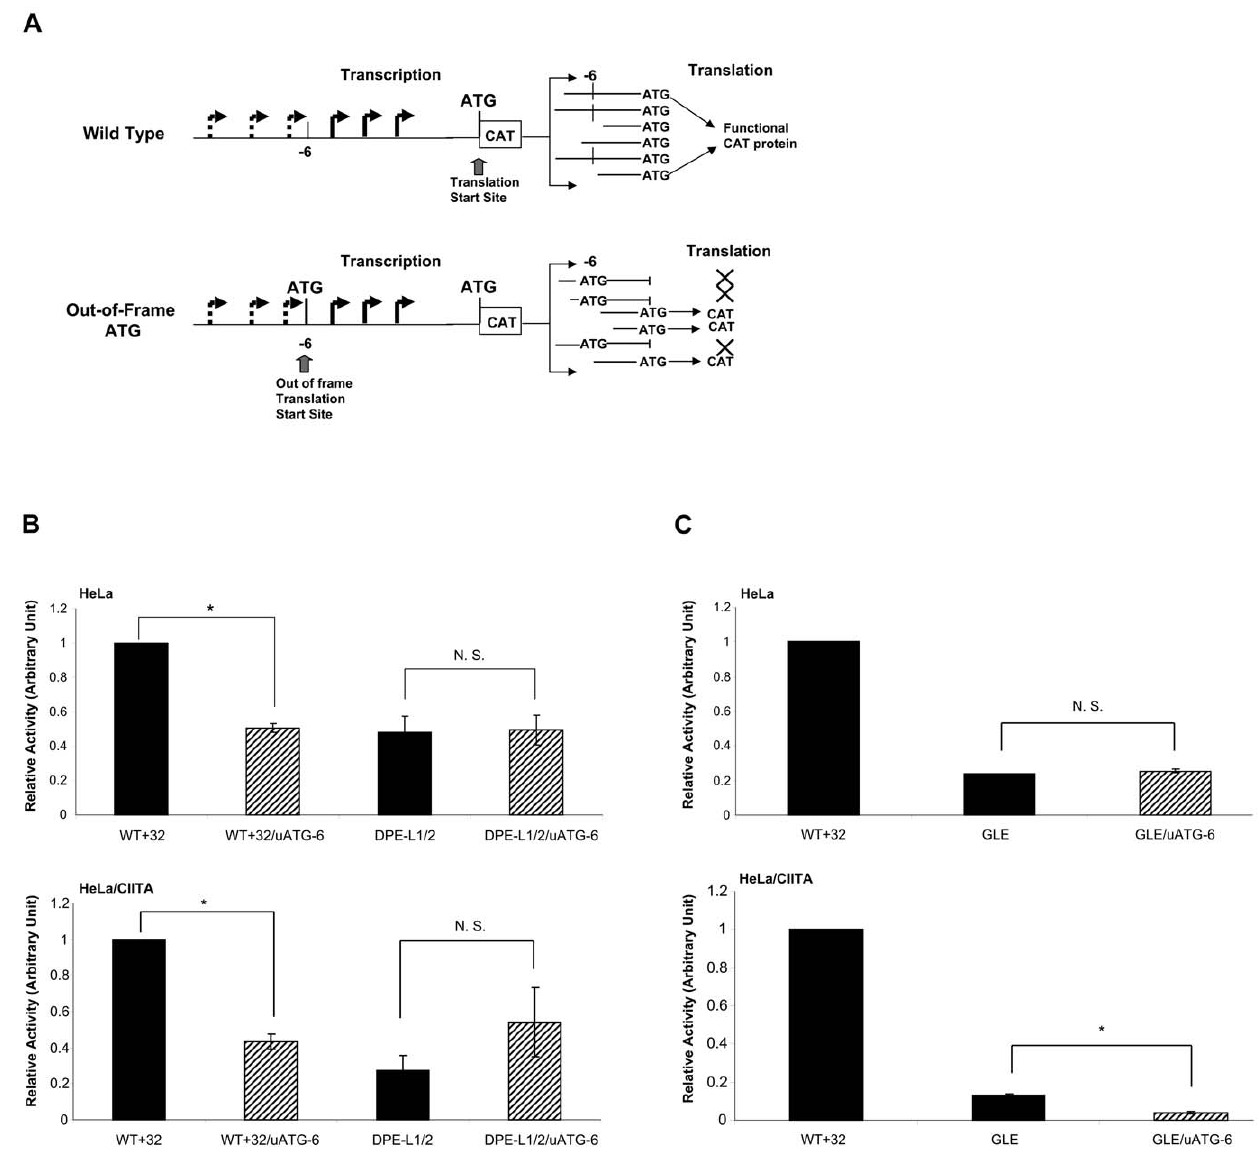
Figure 5. Downstream elements preferentially regulate upstream transcription start sites in constitutive transcription. A) Schematic of the effect that an out-of-frame ATG insertion has on subsequent translation of mRNA. Transcription in the class I promoter starts at multiple sites over a span of approximately 60–70 bp [44]. In the wild type promoter, ligated to the CAT reporter, the first ATG encountered by any of these transcripts is the authentic in-frame translation initiation codon that generates functional CAT protein (upper panel). Insertion of an ATG at the 2 6 bp position results in out-of-frame translation of any mRNAs that initiated upstream of 2 6 and abortive protein synthesis, whereas translation of transcripts that initiated downstream of 2 6 bp initiates from the authentic ATG and generates CAT enzyme. Thus, the out-of-frame ATG allows transcripts initiating downstream of 2 6 bp to be distinguished from those starting upstream. (The indicated start sites are conceptual, to illustrate the strategy, and not intended to denote actual start sites.) The complete strategy and characterization are described in the Results section and [41]. B) DPE-Ls preferentially target transcription initiating at upstream sites in both constitutive and activated transcription. HeLa cells (upper panel) or HeLa/CIITA cells (lower panel) were transfected with either a wild type (WT + 32) construct; one with an out-of-frame ATG created at 2 6 bp (WT + 32/uATG 2 6 ); a wild type promoter with mutated DPE-L1 and DPE-L2 (DPE-L1/2); or the out-of-frame ATG promoter construct with mutated DPE-L1 and DPE-L2 (DPE-L1/2/uATG 2 6 ). The amount of CAT activity relative to the WT + 32 was determined as described in Materials and Methods. Whereas the activity of WT + 32/uATG 2 6 is significantly differently from WT + 32, the activity of DPE-L1/2/uATG 2 6 is not significantly different (N.S.) from that of DPE-L1/2 in either cell line. (*) denotes a significant difference between the activities of WT + 32 and WT + 32/uATG 2 6 . C) GLE targets upstream start sites in constitutive transcription and downstream start sites in activated transcription. HeLa cells (upper panel) or HeLa/CIITA cells (lower panel) were transfected with the wild type WT + 32, the mutated GLE promoter or the out-of-frame ATG promoter construct with a mutated GLE enhancer, GLE/uATG 2 6 . The amount of CAT activity relative to the WT + 32 was determined. While GLE/uATG 2 6 is not significantly different from GLE in constitutive transcription in HeLa cells (upper panel), GLE/uATG 2 6 is significantly different from GLE in CIITA-activated transcription in HeLa/CIITA cells (bottom panel). (*) denotes a significant difference between the activities of GLE and GLE/uATG 2 6 .